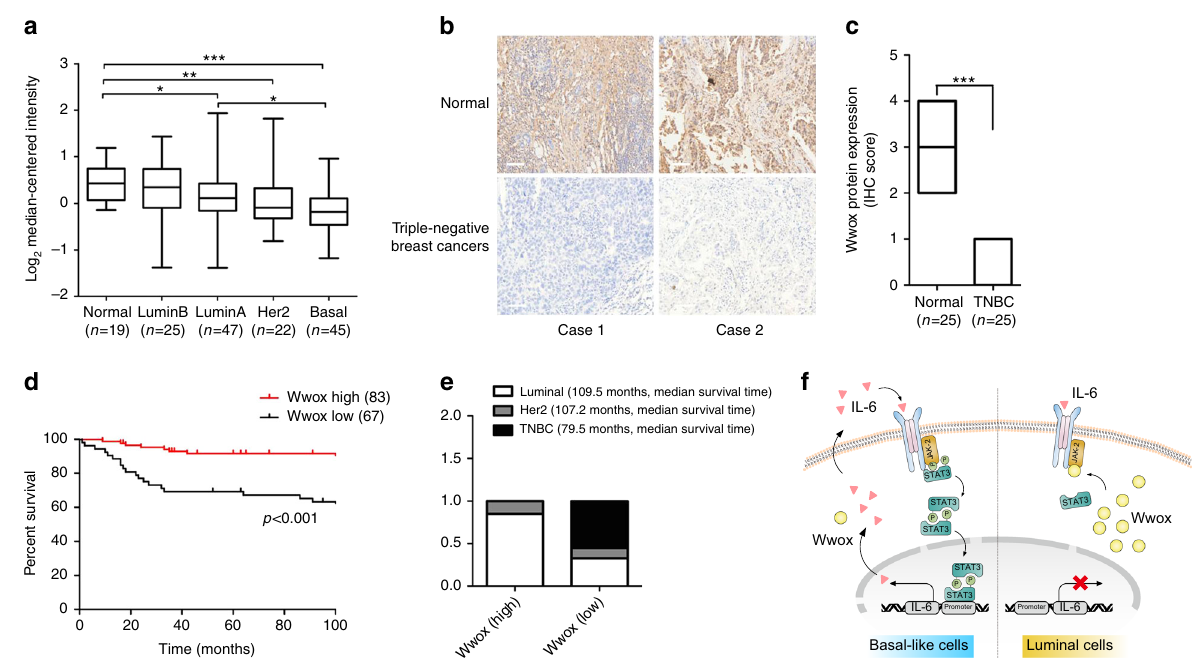
Fig. 6 The levels of Wwox expression in breast cancer (BC) have prognostic implications. a The mRNA expression pro fi les of Wwox in normal breast tissues and in different molecular subtypes of BC; * p < 0.05, ** p < 0.01, *** p < 0.001. Student ’ s t -test. b , c IHC staining for Wwox in adjacent normal and paired triple-negative BCs (TNBCs) ( b ). Box plots of Wwox protein expression assessed by blinded IHC analyses of 25 normal and paired TNBC tissues ( c ); *** p < 0.001, Student ’ s t -test. Scale bar, 100 μ m. d Kaplan – Meier curves for overall survival in 150 human BC patients classi fi ed by relative (high or low) immune signal for Wwox protein levels. The log-rank (Mantel – Cox) test p value re fl ects the signi fi cance of the correlation between Wwox positivity and longer survival outcomes; *** p < 0.001, log-rank test. e The percentage of Wwox protein levels in different subtypes of 150 human BC samples. The de fi nitions of 'high' and 'low' are given in the Methods section. f A model of the regulation of STAT3 activity by Wwox in BC. Wwox inhibits JAK2 phosphorylation and attenuates the interaction between JAK2 and STAT3, suppressing STAT3 phosphorylation and inhibiting IL-6